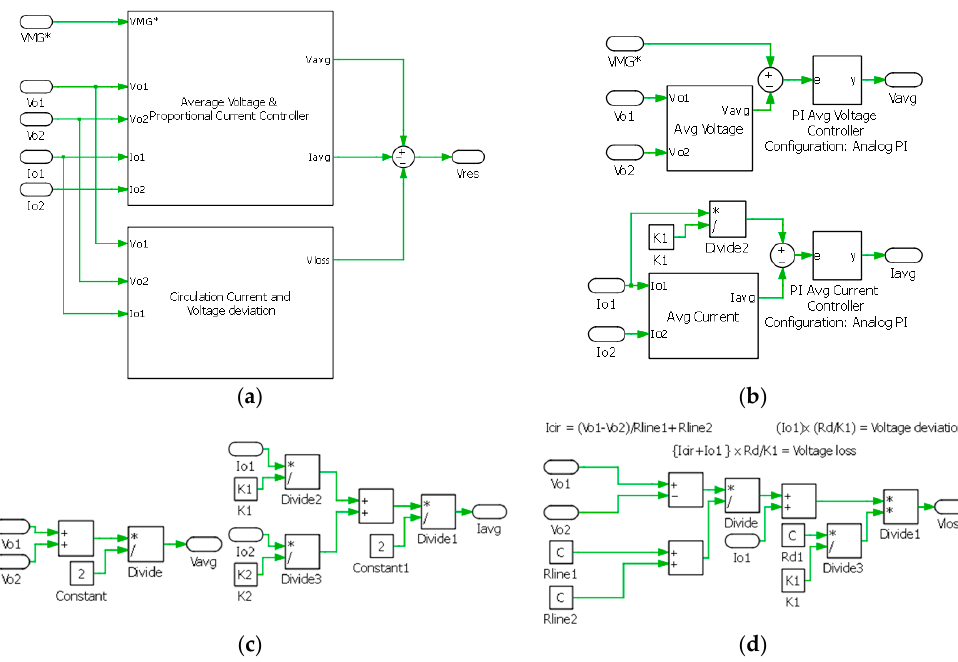
Figure 5. The Secondary controller design: ( a ) The proposed Secondary controller, ( b ) The average voltage and average proportional current controller, ( c ) Internal view of average voltage and average proportional current controller, ( d ) The circulating current and voltage deviation controller.